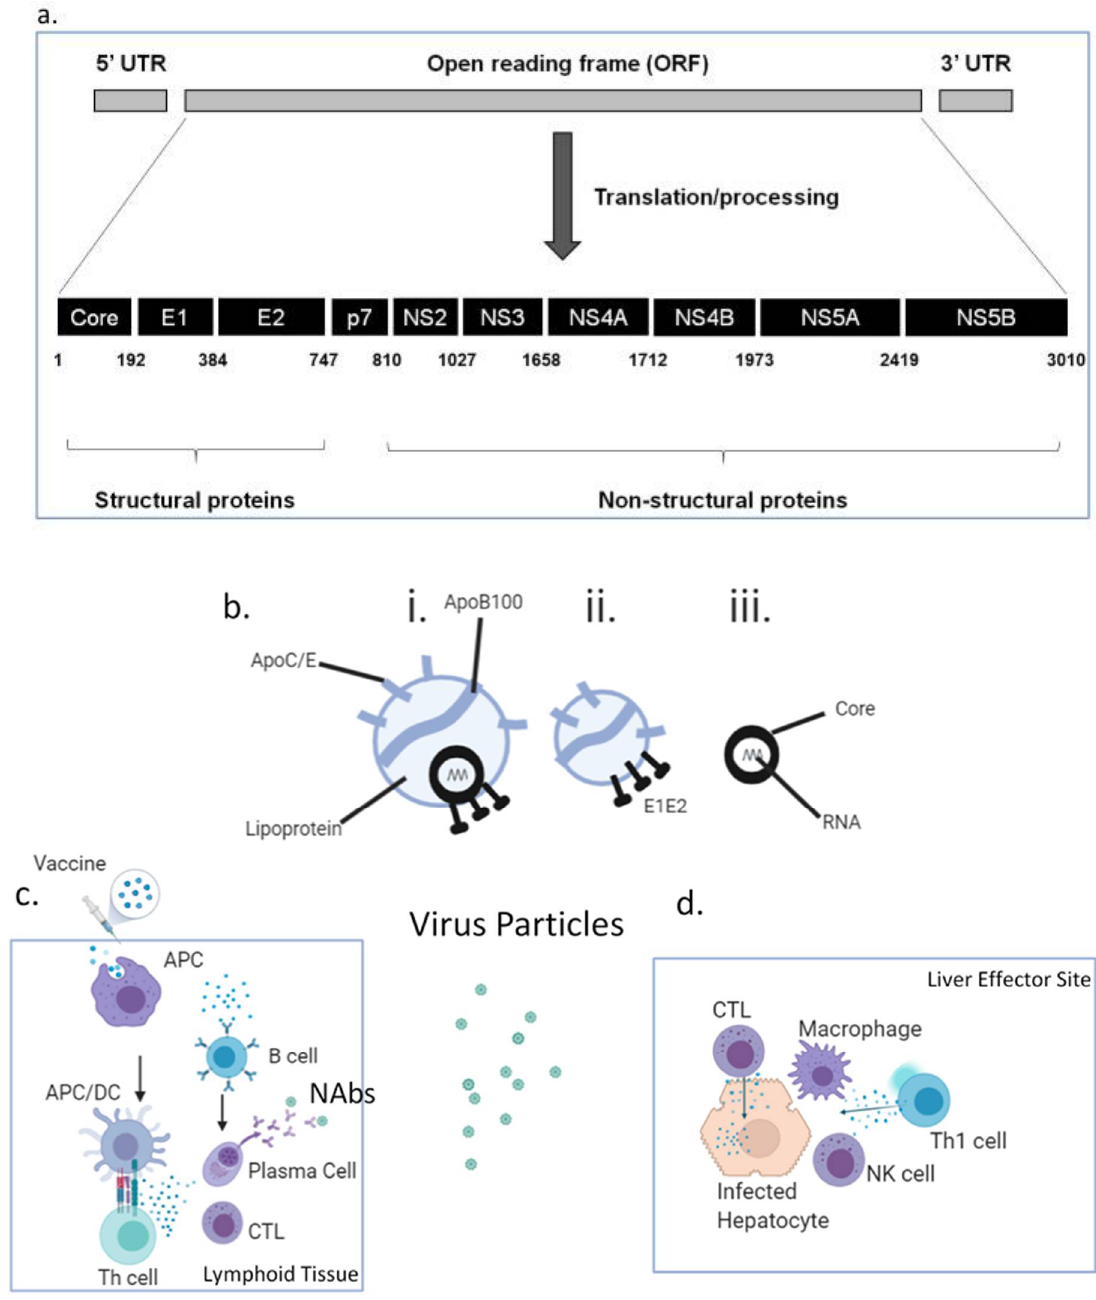
Figure 1. HCV proteins (antigens), dynamic composition of HCV particles, and indicative mechanisms (non-exhaustive) of vaccination and anti-viral immune protection. ( a ) The single stranded 9.6 kb RNA genome encodes a long open reading frame (ORF), which is flanked by 2 untranslated regions (5' and 3' UTR). The translated polyprotein is co-translationally and post-translationally processed by cellular and viral proteases. The numbers below the polyprotein denote the amino acid positions of the respective cleavage sites. (b) The unique and dynamic composition of the HCV particles circulating in the blood: (i) infectious HCV lipoviral particles (LVP), (ii) subviral particles, and (iii) non-enveloped core particles. ( c ) Potential vaccination process involving injection of vaccine, uptake by Antigen Presenting Cells (APCs particularly Dendritic Cells [DCs]), processing and presentation to T cells (Th cells and cytotoxic T cells (CTLs)), as well as viral recognition by B cells and the production of specific antibodies. ( d ) Potential effector mechanisms against HCV involve recognition of infected hepatocytes by CTLs and their secretion of cytolytic granules, recognition of antigen by Th1 cells and secretion of interferon (IFN) γ that activates local NK cells and macrophages. Created with